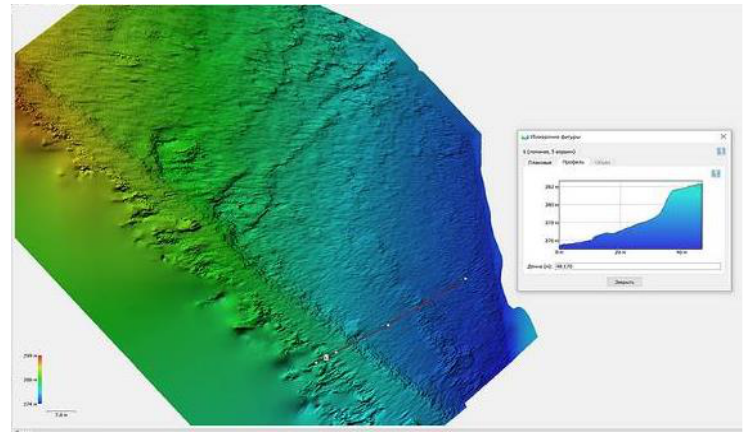
Figure 3. Relief profile using the Agisoft PhotoScan program.